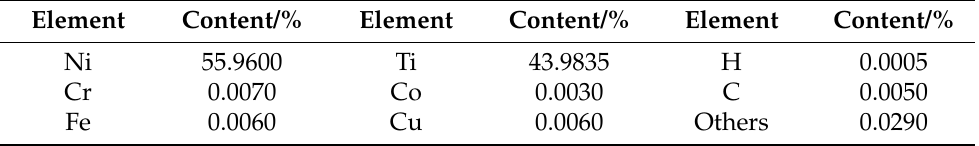
Table 1. Composition of the shape memory alloy (SMA).